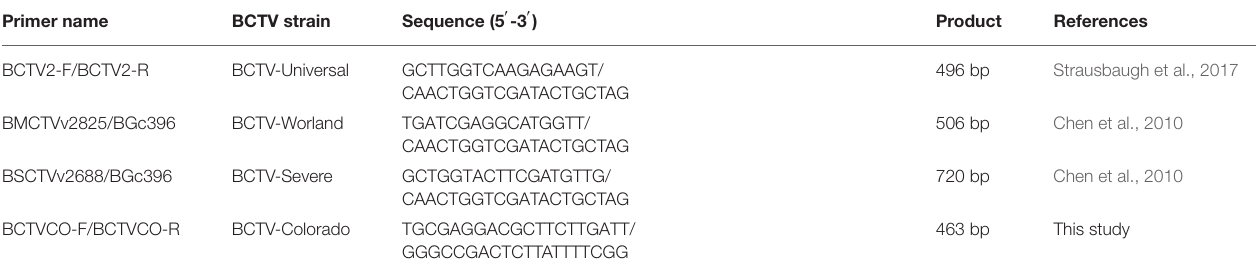
TABLE 1 | Primers used to detect beet curly top virus (BCTV) strains in hemp ( Cannabis sativa